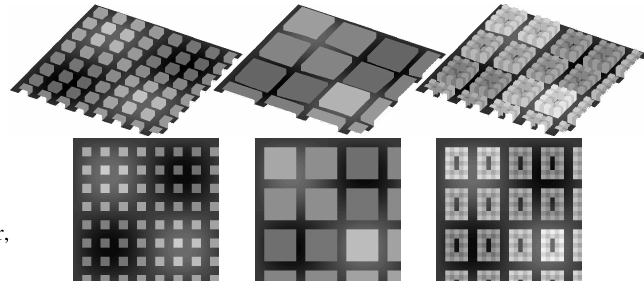
Figure 3: Synthetical DSMs, top: 3D view, bottom DSM; left: rectangular buildings (32 m), center: industry buildings (112 m), right: urban blocks (80 m × 112 m, each block 16 m); all streets between buildings 32